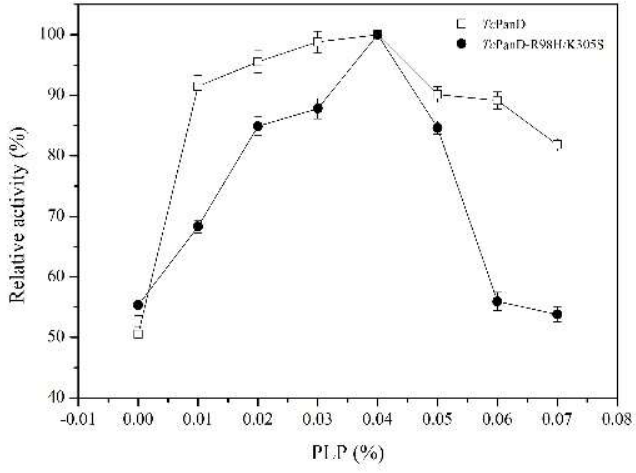
Figure 3. Effect of pyridoxal 5’-phosphate (PLP) addition on TcPanD and TcPanD-R98H/K305S.Data are given as mean ± SD, n = are given as mean ± SD, n = 3.